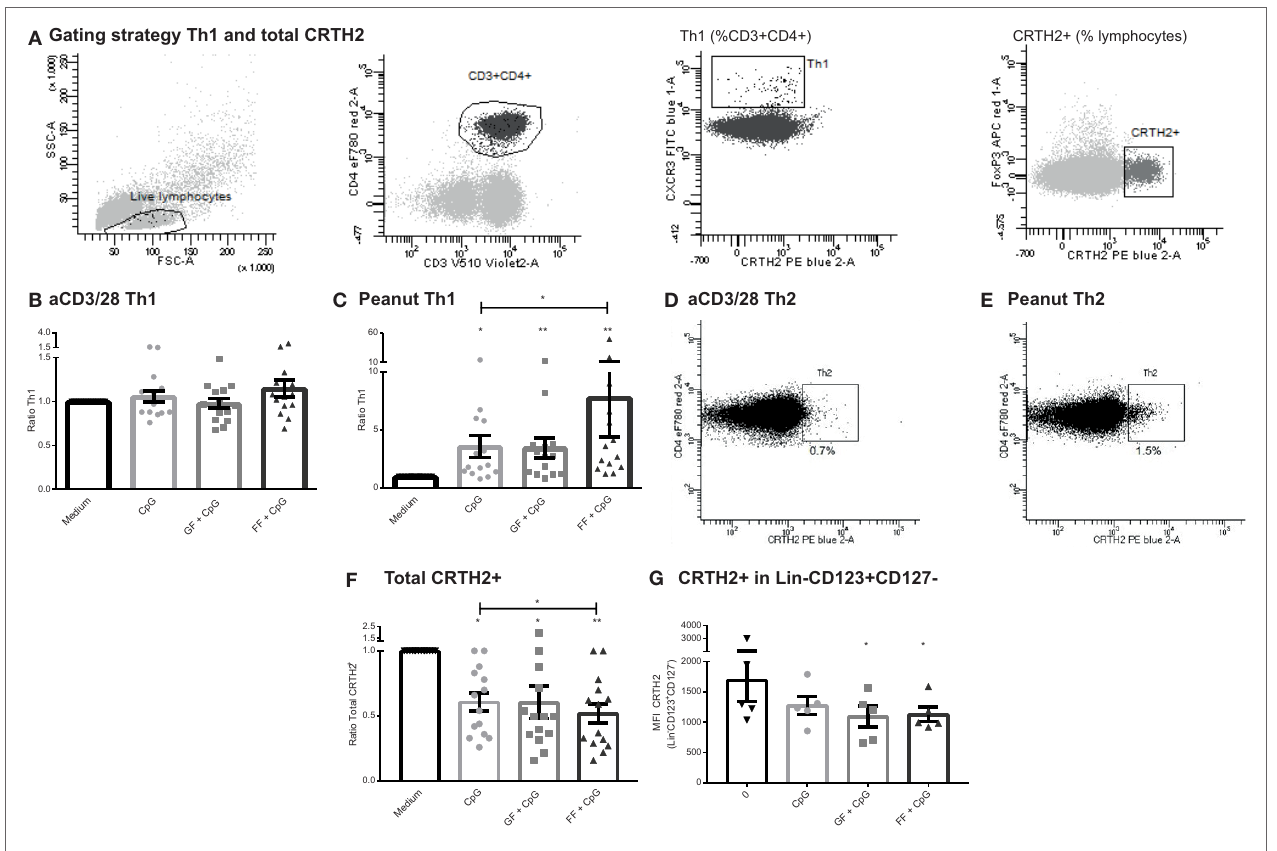
FigUre 7 | Increased T helper 1 (Th1) subset in a peanut-specific co-culture model upon exposure of intestinal epithelial cells (IECs) to CpG, while CRTH2 is downregulated. Gating strategy of Th1 and CRTH2 + cells (a) . The Th1 subset of the aspecific co-culture model was not affected after CpG exposure of IECs (B) . In the peanut-specific model, IECs exposed to CpG oligodeoxynucleotides (ODN) mediated an increase in the basolateral Th1 population, which was further enhanced by short- and long-chain fructo-oligosaccharides (scFOS/lcFOS) (FF) (c) . A representative patient shows that the percentage of Th2 cells was higher in the peanut-specific model (D,e) . A significant decrease in surface marker CRTH2 in the peanut-specific peripheral mononuclear cells fraction was observed, after apical exposure of IECs to CpG ODN, which was further decreased by scFOS/lcFOS (F) . Reduction of Lin − CD123 + CD127 − coincided with a reduction in CRTH2 expression in this cell subset (g) . N = 15 peanut-allergic patients, mean ± SEM, * P < 0.05, ** P < 0.01, *** P < 0.001 by one-way ANOVA, scGOS/lcFOS